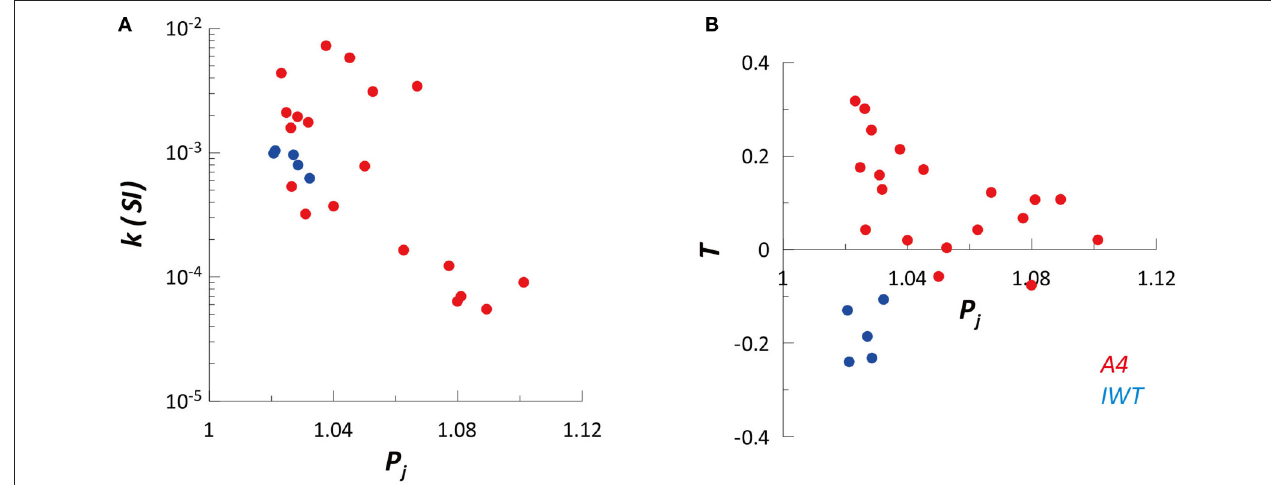
FIGURE 7 | (A) Mean values of magnetic susceptibility are inversely proportional to the degree of anisotropy ( P j ). (B) Magnetic fabric was analyzed by comparing P j in relation to the shape parameter ( T ). While the A4 member showed a prevalent oblate fabric, the IWT showed a dominance of prolate fabric.